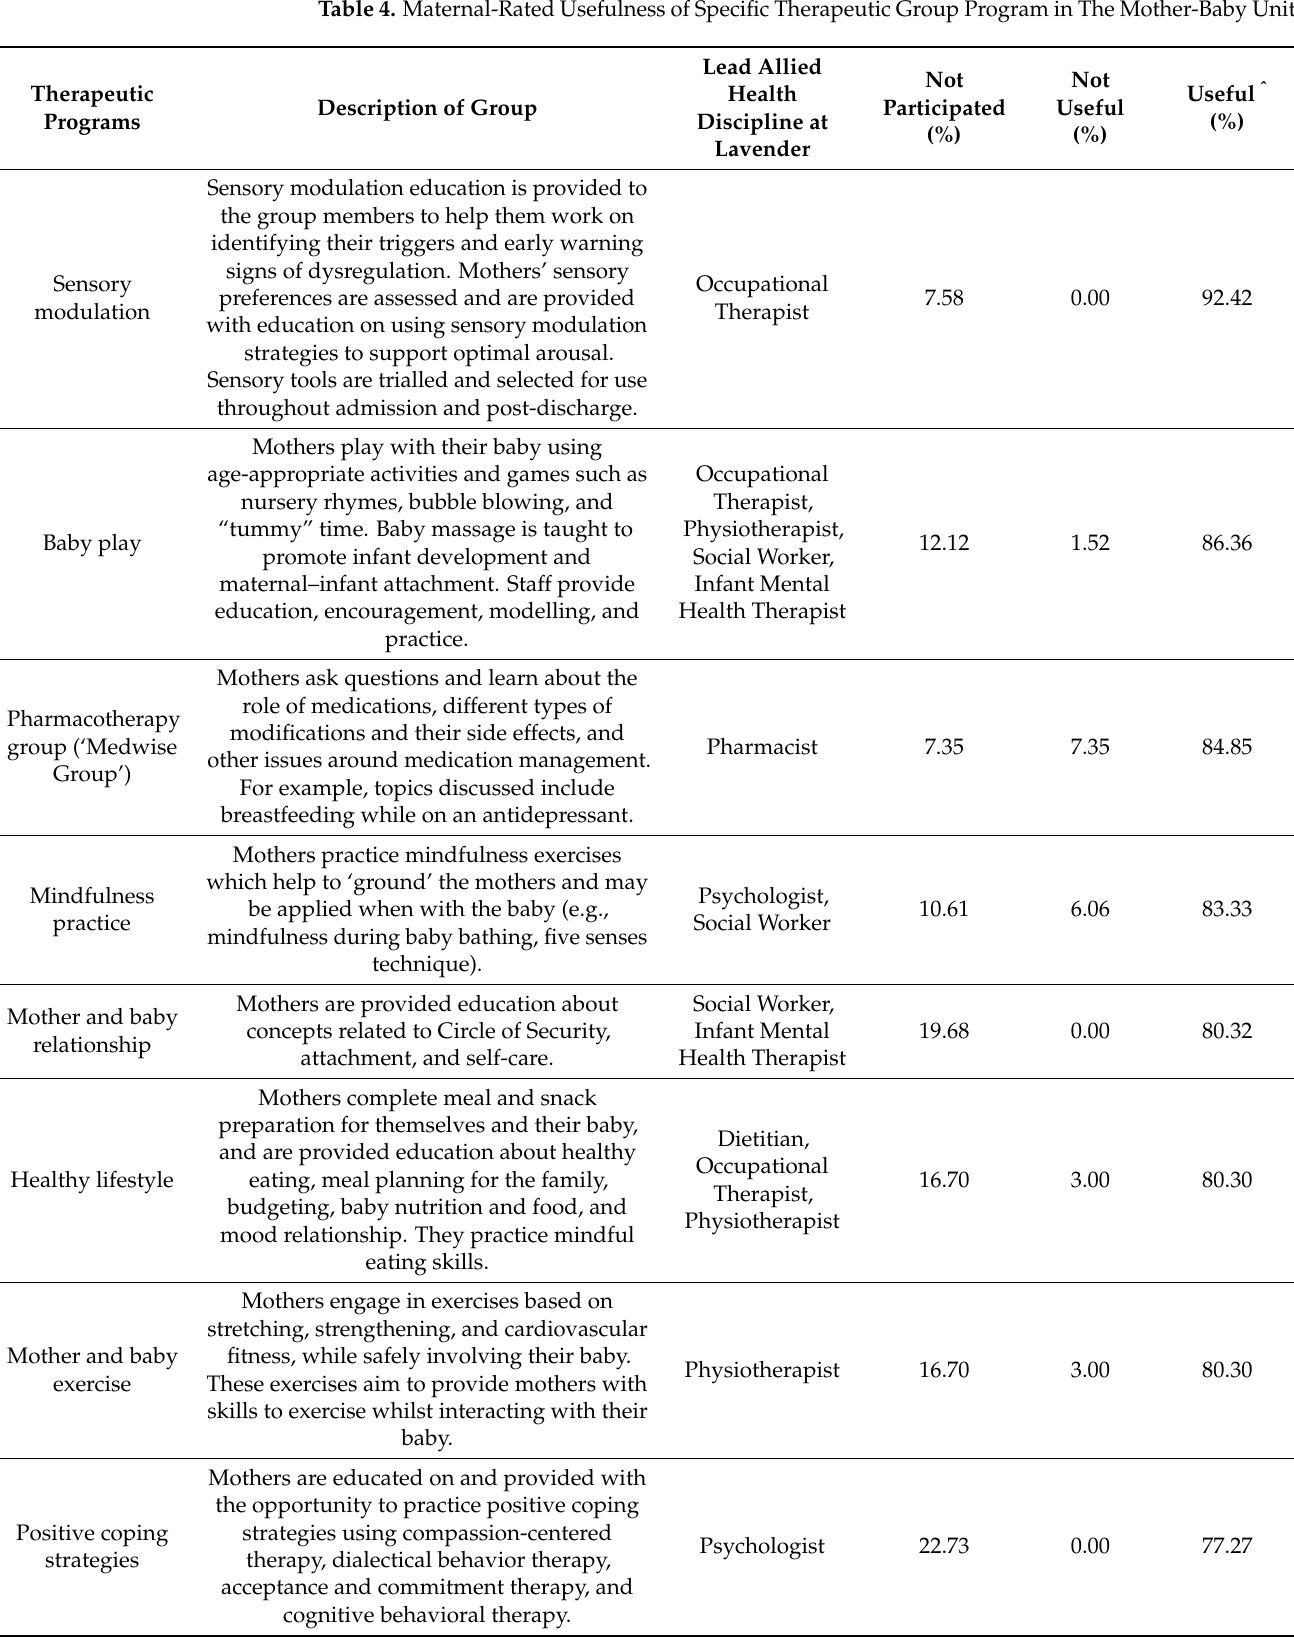
Table 4. Maternal-Rated Usefulness of Specific Therapeutic Group Program in The Mother-Baby